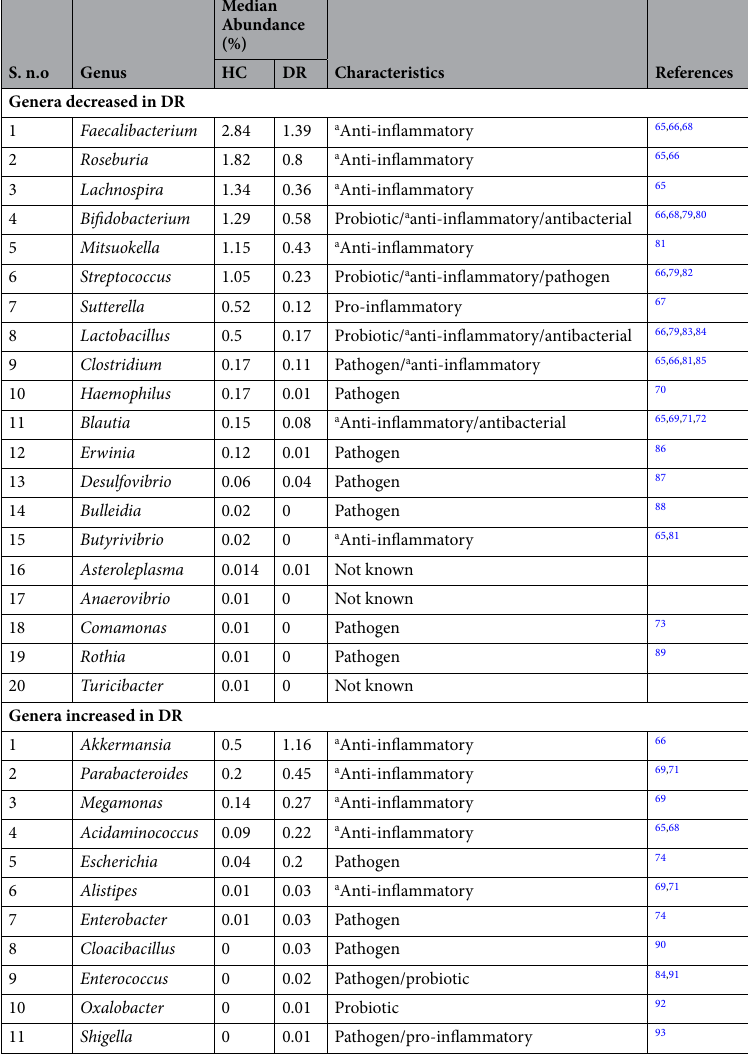
Table 4. Bacterial genera exhibiting significant differential abundance (BH corrected p < 0.05) between the gut microbiomes of healthy controls (HC, n = 30) and diabetic retinopathy (DR, n = 28) individuals. a Based on the capability to produce short chain fatty